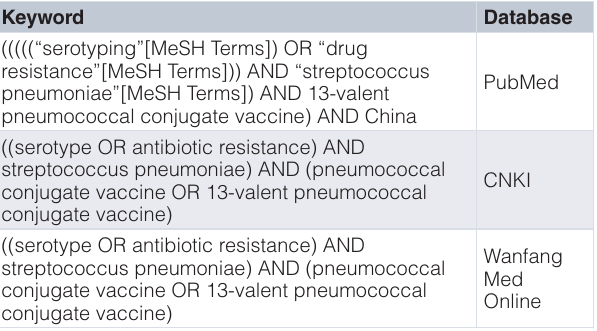
Figure 1. Summary of search strategy. Table 2. Planned search syntax.